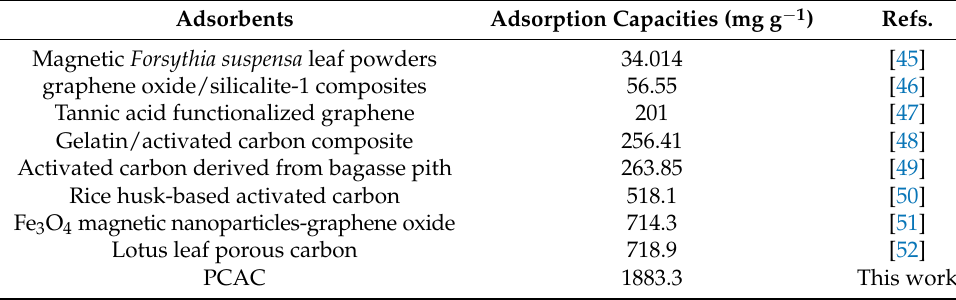
Table 2. Maximum adsorption capacities of RhB on adsorbents.